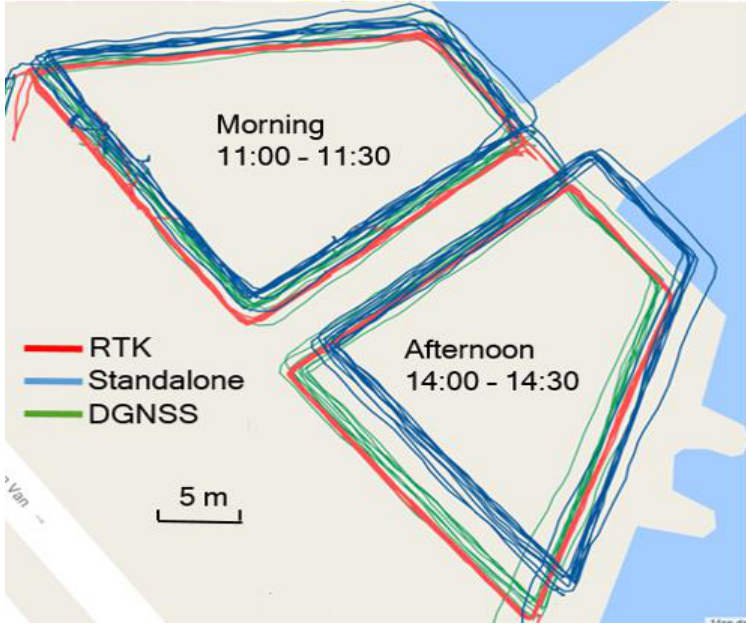
Figure 7. Smartphone performance comparison between the morning and the afternoon.